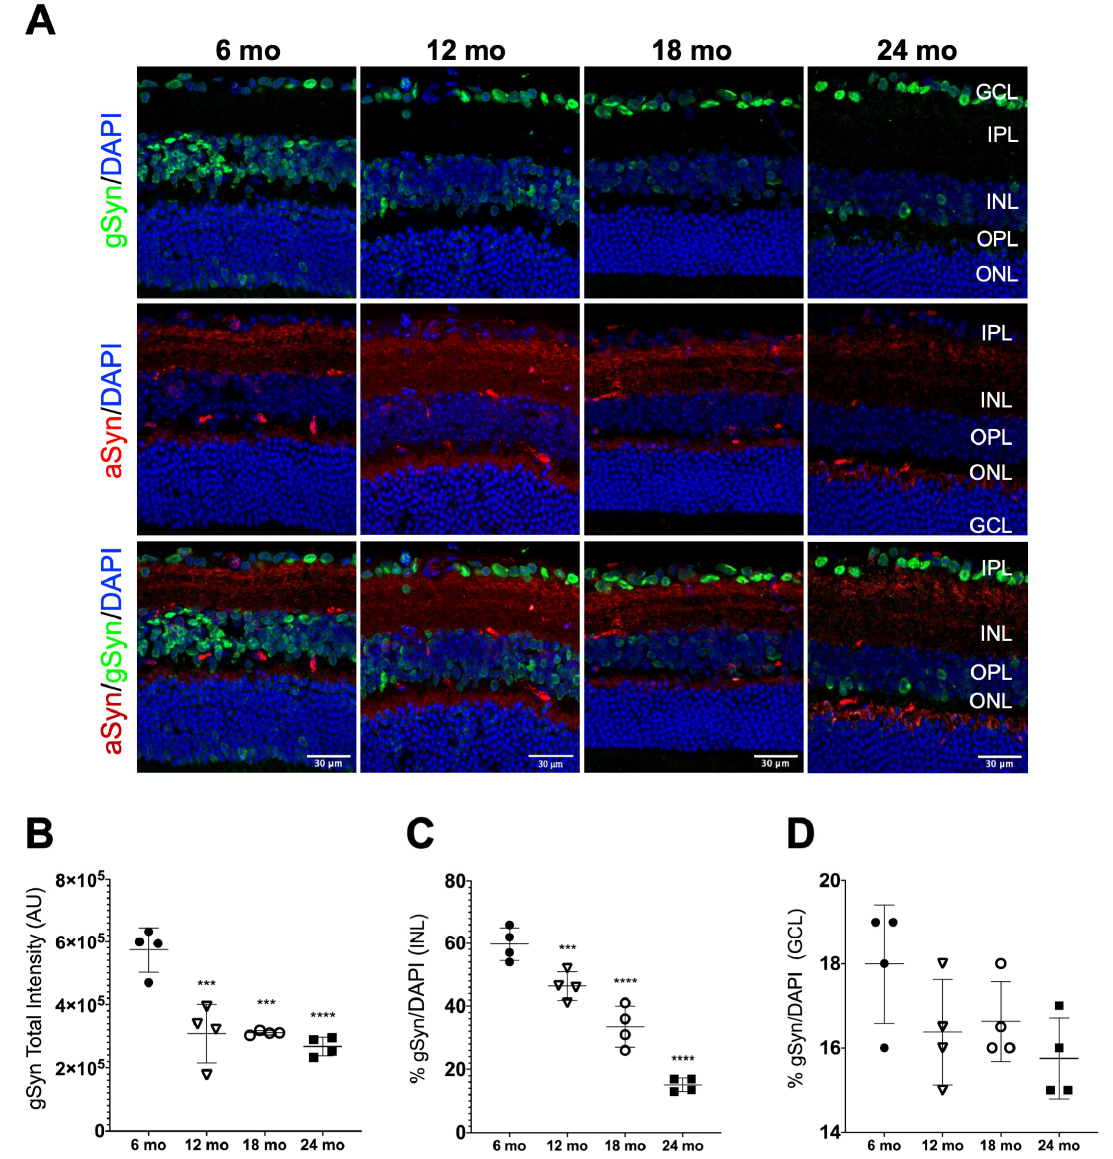
Figure 4. gSyn distribution profile in mice retinas. ( A ) Representative immunofluorescence of gSyn (green) and aSyn (red) merged with nuclear DAPI staining of retinal sections at the indicated ages. ( B ) Quantification of gSyn fluorescence intensity in all retinal layers ( n = 4). ( C ) The gSyn-positive cell body count in the GCL and ( D ) in the INL ( n = 4). Scale bar = 30 µm. Fluorescence intensity analysis was performed using approximately 4 representative images of the central region of the retina from each animal per age group. Values are represented by mean ± SD. Mice of 12 ( ∇ ), 18 ( and 24 months of age (mo) ( (cid:4) ) were compared to 6 mo ( • ) mice using an ordinary one-way ANOVA multiple comparison test (*** p < 0.001 and **** p <